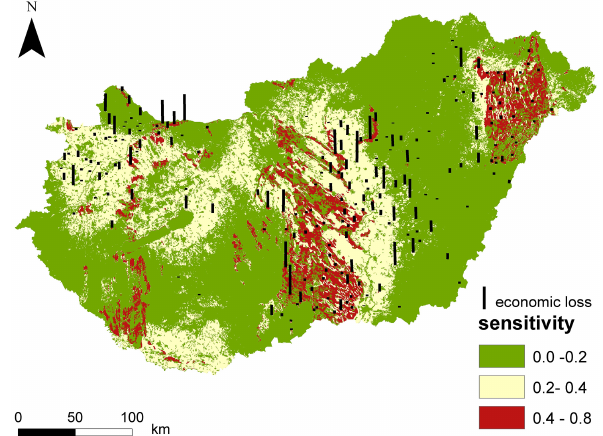
Figure 14. Economic losses based on the data from the state in- surance company from the period 1977–1986 (source: Szabó et al., 1994) overlaid with the three regional sensitivity